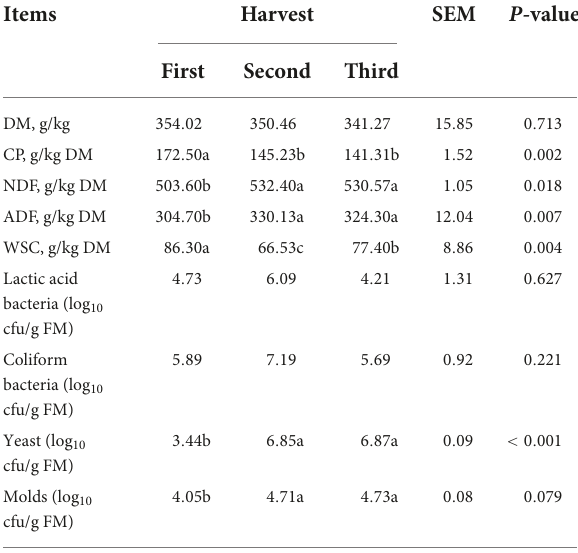
TABLE 1 Chemical and microbial compositions of fresh